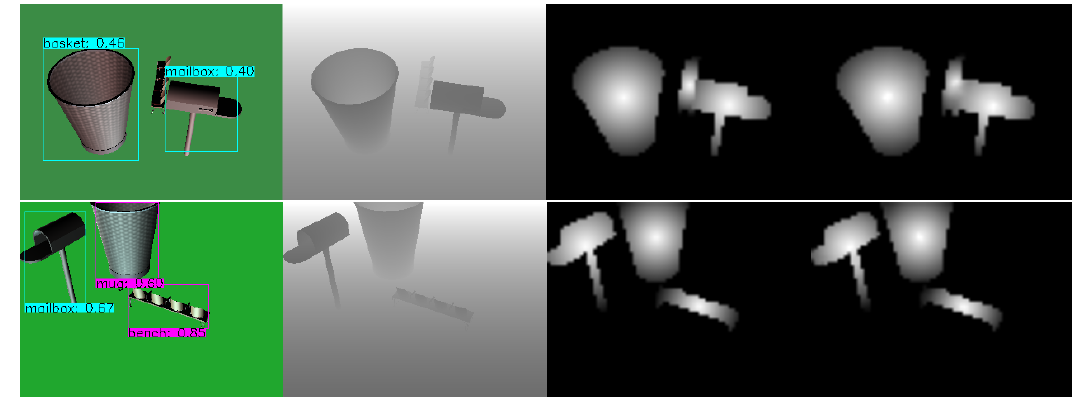
Figure 11. Prediction made with our extended YOLOv3 network. Left to right: (1) Input color image with predicted object instances; (2) Input depth frame; (3) Upscaled to 320 × 240 ground truth